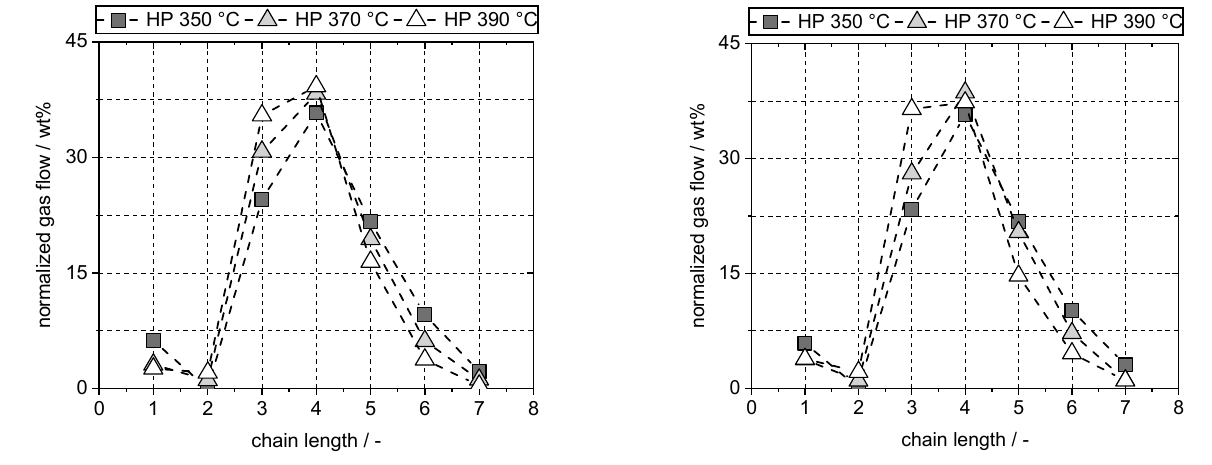
Figure 17. Chain length distribution of hydrocarbon gases produced during hydroprocessing of PW ( left ) and FTW ( right ).